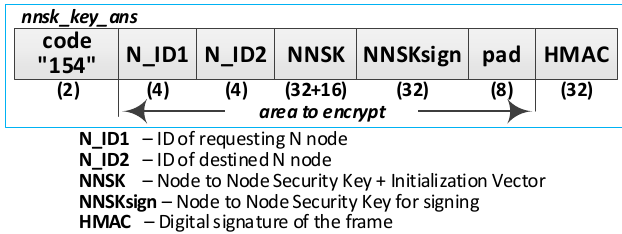
Figure 24. Response to the session key request frame.